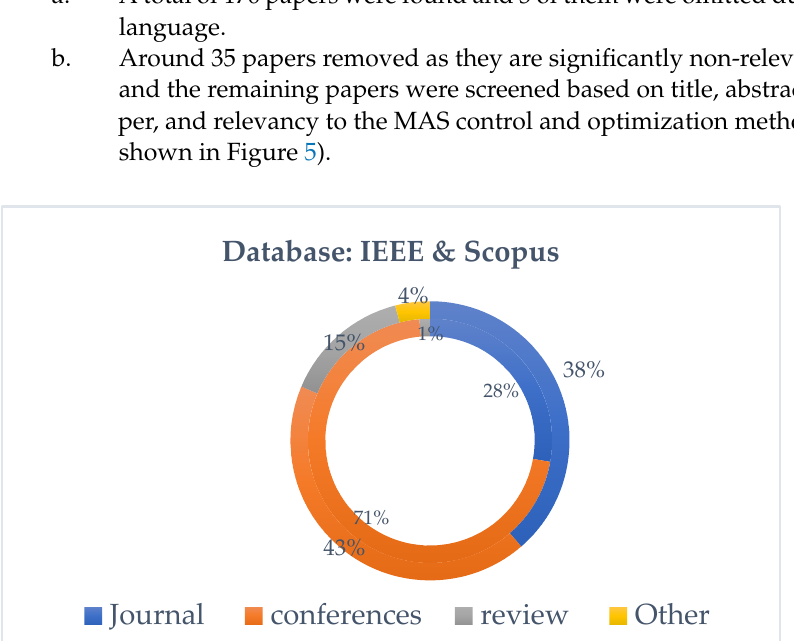
Figure 4. Categorizing the systematic literature review.